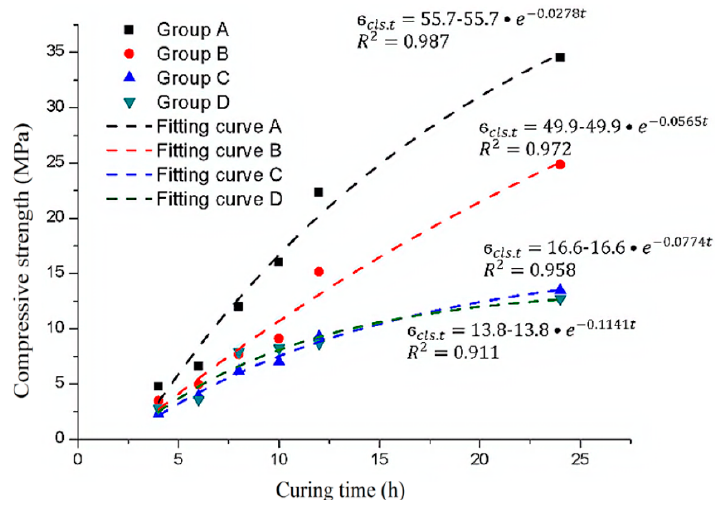
Figure 14. The experimental data and exponential function fitting curve of the ultimate compressive strength of the samples with different sulfate solution concentrations.